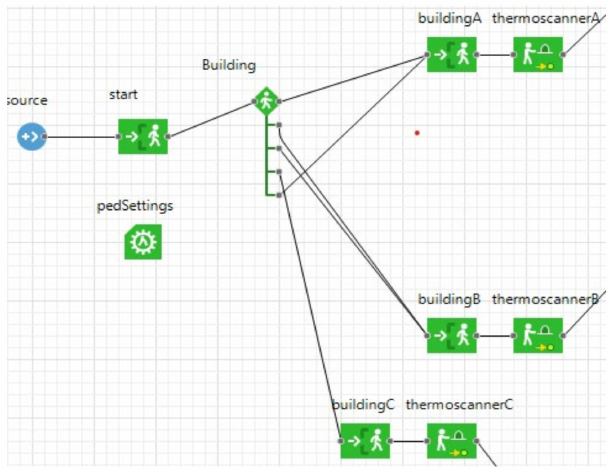
Figure 6. Entities’ creation and entrance.